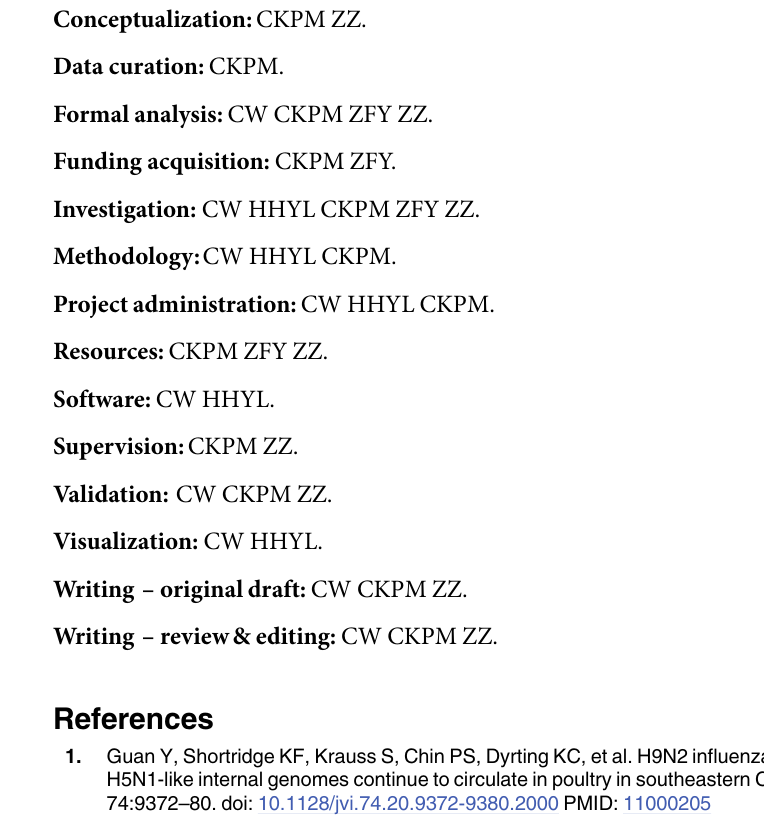
Fig 7. Lung cell characterization following infection with H9N2/G1 and the PB2 mutants. BALB/c mice were infected intranansally with 1.5x105 PFU of H9N2/G1 or the PB2 mutants. Cell sub-populations(A) T cells (B) Neutrophils (C) Macrophages (D) Dendritic cells (E) NK cells were collected from the lungs and were gated with antibodiesat various times post-inoculation. The data shown represents the mean number of cells and standard deviations from four mice per time point, * p < 0.05 compared to the H9N2/G1wt. (F-J) The percentageof NP positive cells from the subpoplutions. Gating: T cells(CD3+/CD11c-/CD11b-/Ly6G/C-), Neutrophils(CD11b+/CD11c-/CD3-/Ly6G/C+),Macrophages(CD11b+/CD11c-/CD3-/ Ly6G/C-), Dendritic cells(CD11c+/CD11b-/Ly6G/C-/CD3-), NK cells(Dx-5+/CD3-). The data is the representative results from one of two independent